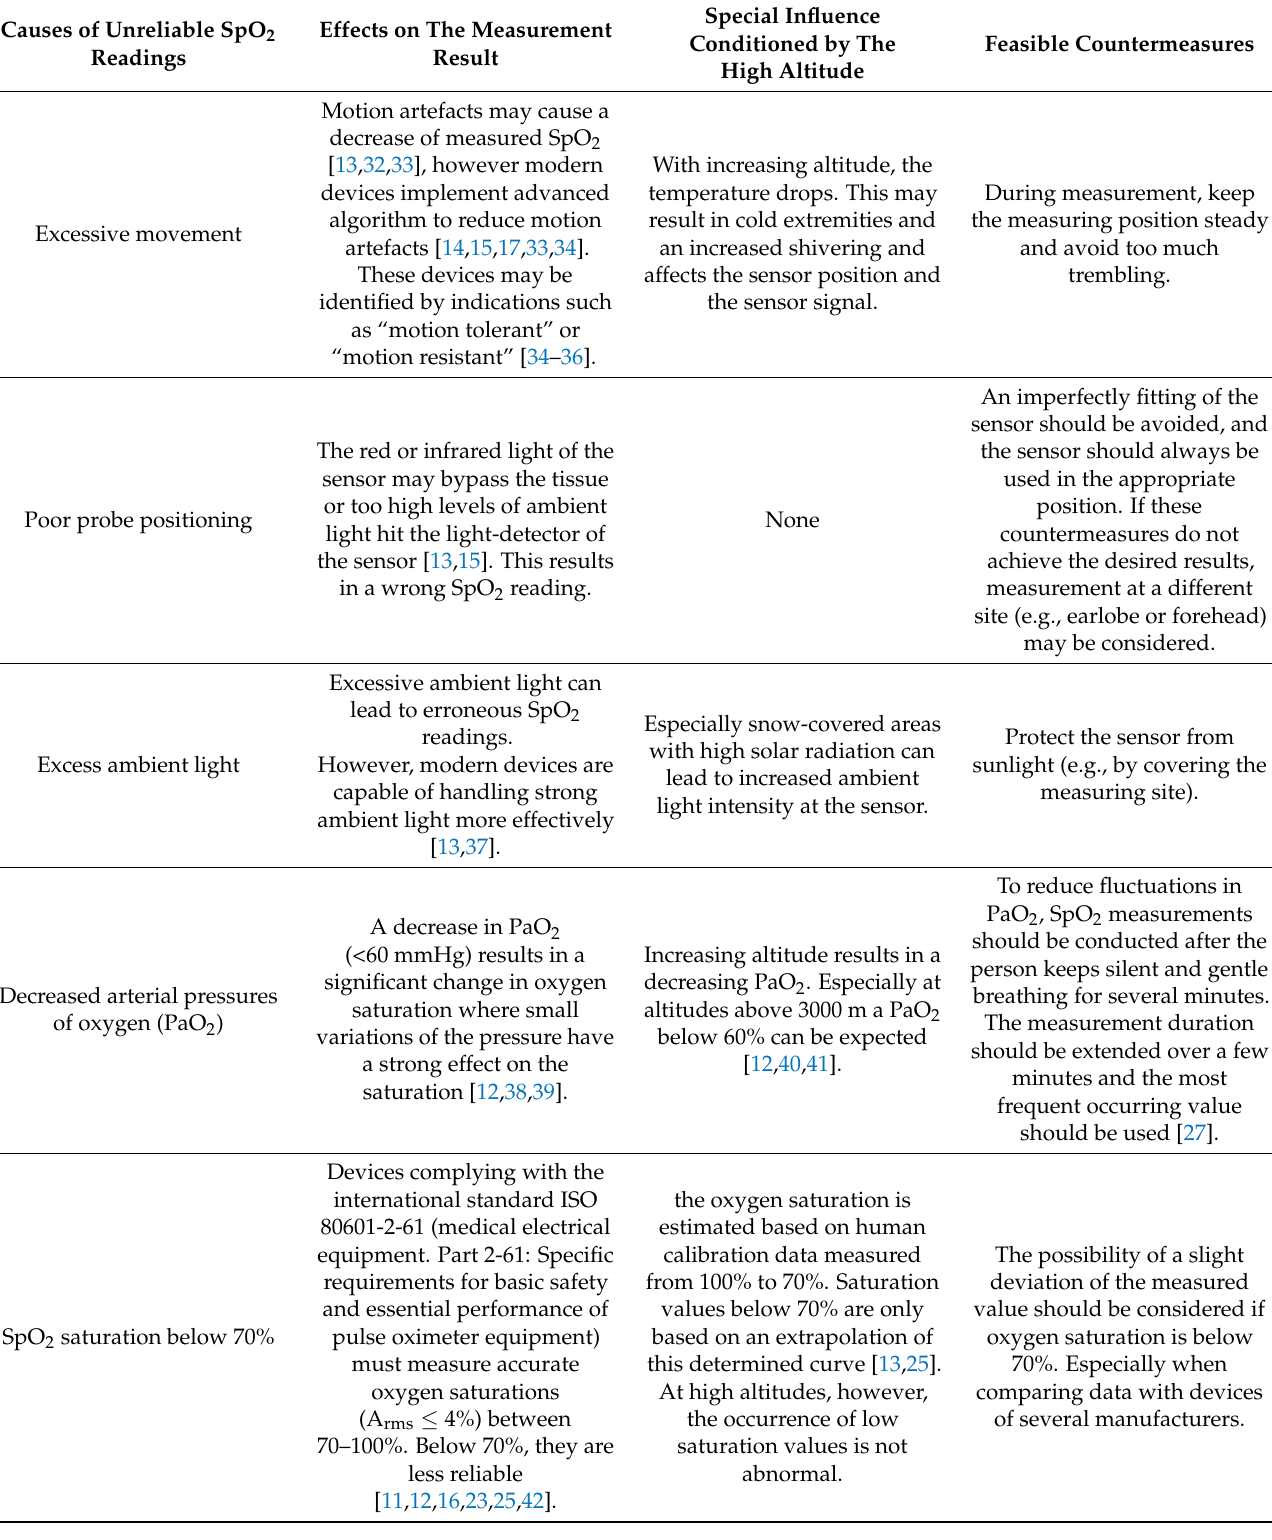
Table 1. Most significant pitfalls and possible countermeasures for pulse oximetry particularly for healthy people at high